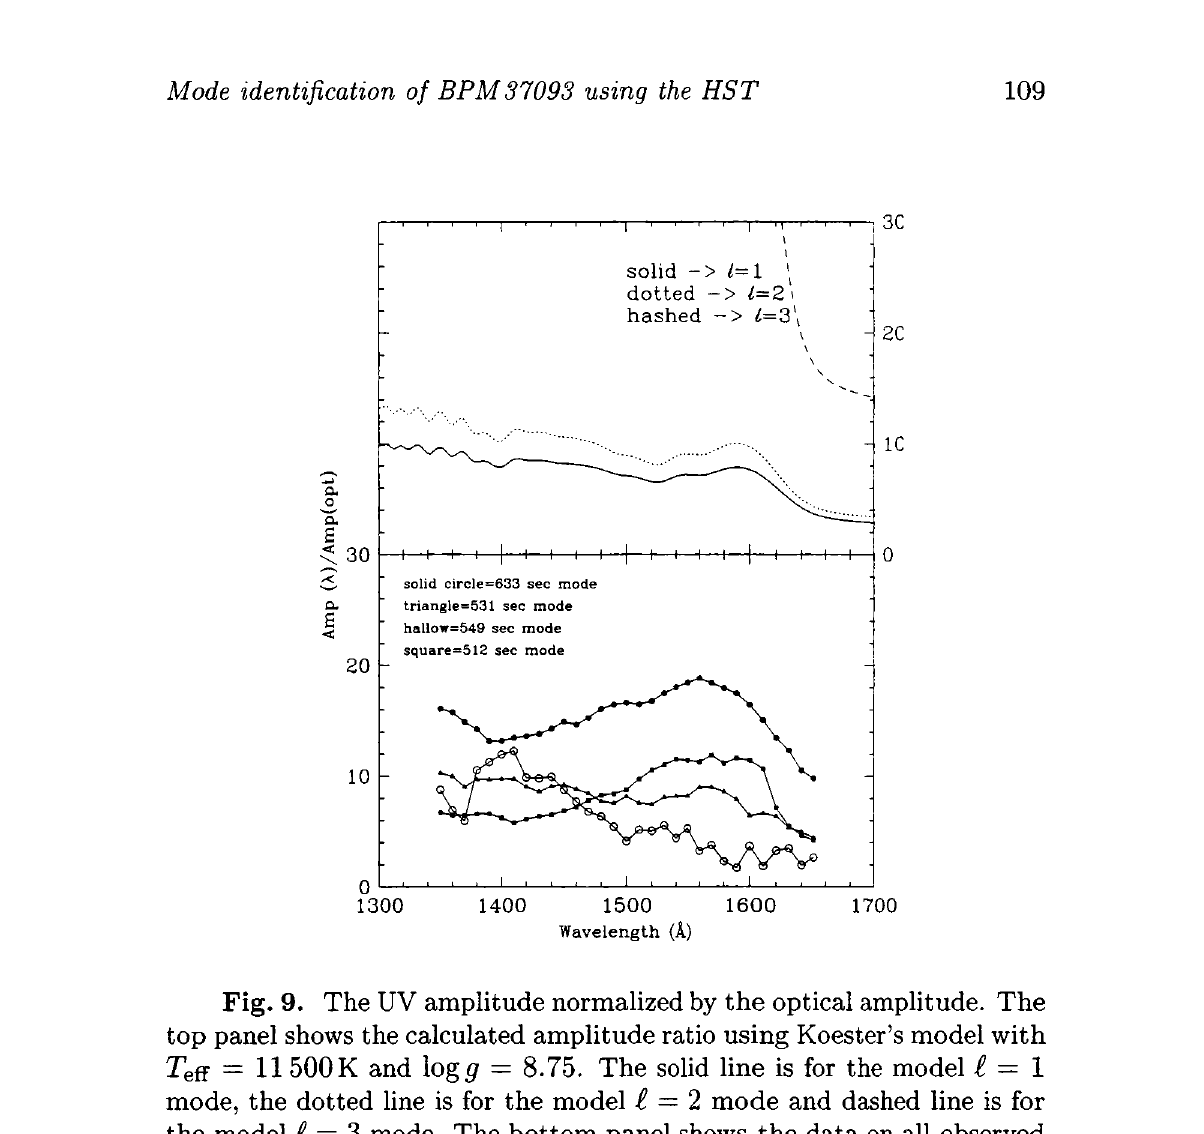
Fig. 9. The UV amplitude normalized by the optical amplitude. The top panel shows the calculated amplitude ratio using Koester's model with Teff = 11 500 K and log g = 8.75. The solid line is for the model I = 1 mode, the dotted line is for the model I = 2 mode and dashed line is for the model i — 3 mode. The bottom panel shows the data on all observed 4